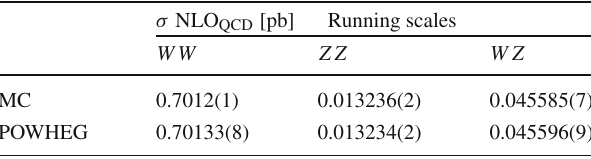
Table 4 Integrated cross sections for the processes pp → e + ν e μ − ν μ , event selection in Eqs. (10) and (11). The factorization and renormal- ization scales are set to the invariant mass of the four-fermion